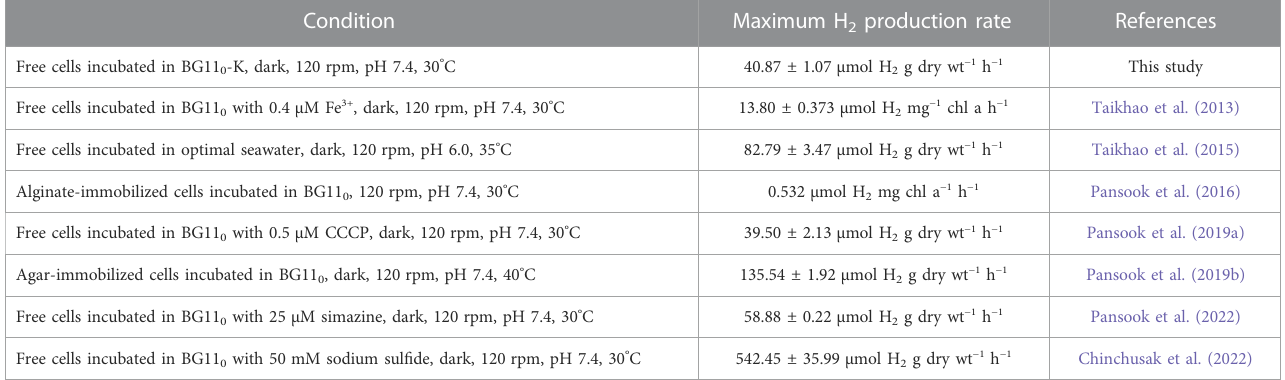
TABLE 3 Maximum dark fermentative H 2 production rate by A. halophytica incubated under various conditions.